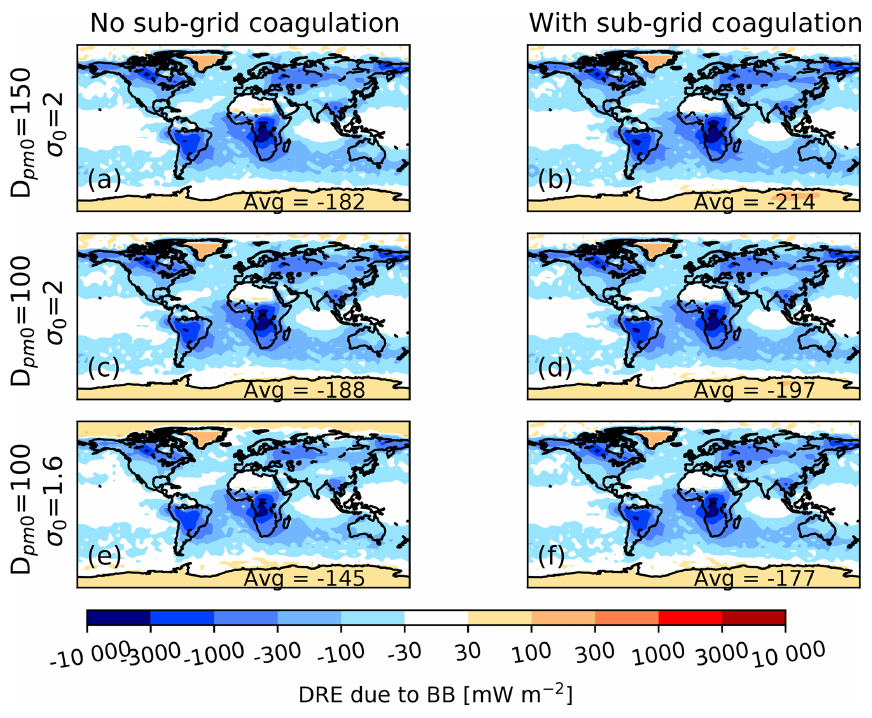
Figure 8. All-sky direct radiative effect (DRE) due to biomass burning aerosols using GFED emissions and the internal, core-shell mixing assumption. Panels (a) , (c) , and (e) are without sub-grid coagulation ( D150_noSubCoag , noSubCoag , and s1.6_noSubCoag , respectively). Panels (b) , (d) , and (f) are with sub-grid coagulation ( D150_SubCoag , SubCoag , and s1.6_SubCoag , respectively). Panels (a) and (b) have an emitted median diameter of 150nm and an emitted modal width of 2. Panels (c) and (d) have an emitted median diameter of 100nm and an emitted modal width of 2. Panels (e) and (f) have an emitted median diameter of 100nm and an emitted modal width of 1.6. The number in the bottom right of each panel is the global mean DRE value (mWm − 2